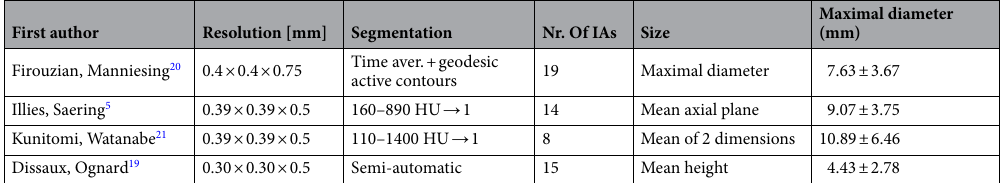
Table 4. All studies included in meta-analysis.